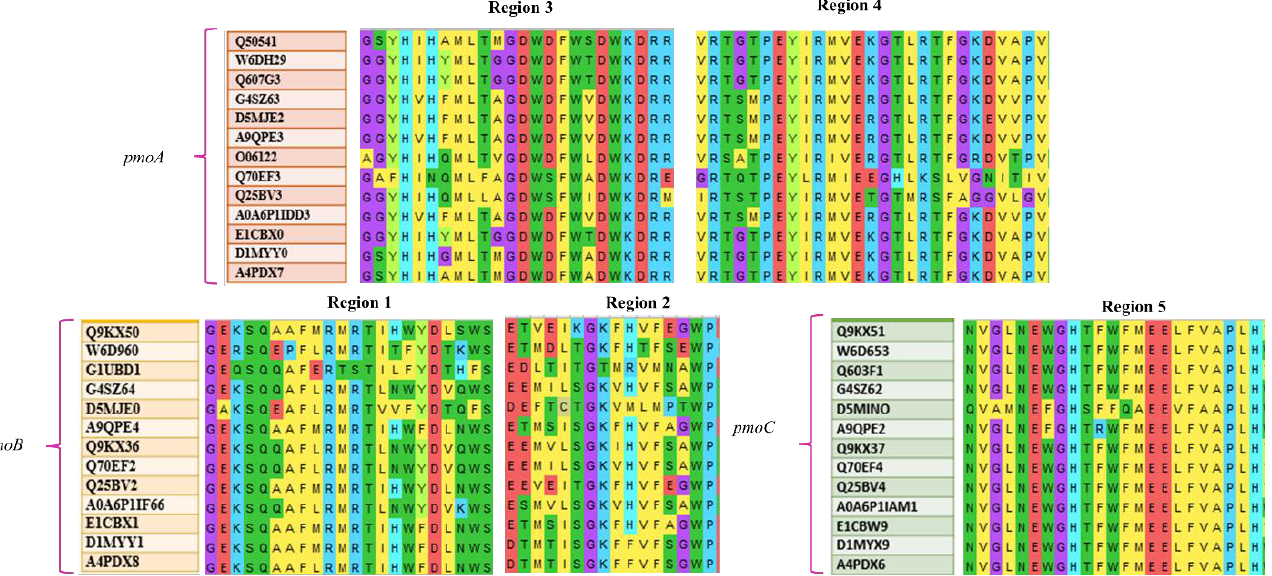
Figure 6. Conserved amino acid residues in pmoA , pmoB , and pmoC (along with UNIPROT accession number of respective species) and the correlation with the pocket regions.